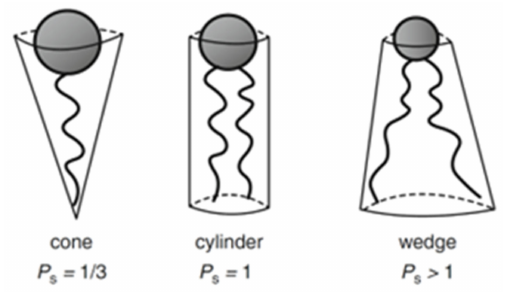
Figure 3. Illustration of the P s concept and relation with geometrical shapes. Adapted from Marques and Silva, 2013